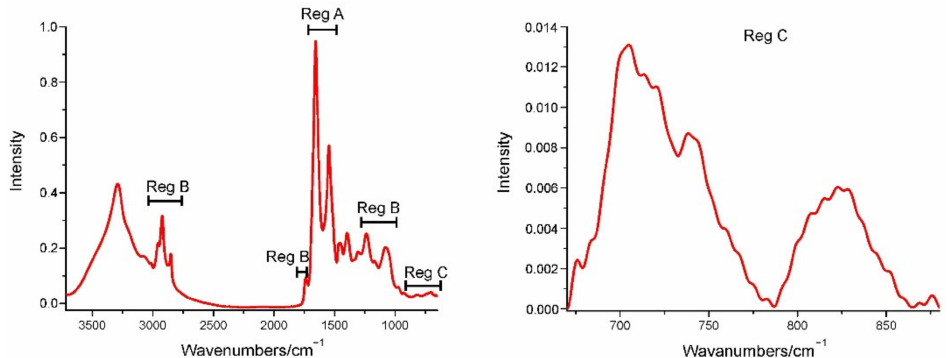
Figure 1. The FT-IR spectra of mouse brain tissue with the regions of interest A, B, C. Region A (Reg A) is the range from 1715 cm − 1 to 1481 cm − 1 representing the protein bands, Region B (Reg B) between the range 3032 cm − 1 to 2810 cm − 1 , 1800 cm − 1 to 1715 cm − 1 and 1285 cm − 1 to 1000 cm − 1 represents the lipid bands, Region C (reg C) between the range 650 cm − 1 to 875 cm − 1 is a region where ν O–O of peroxides and ρ CH 2 of lipids appears, vital for the oxidative stress